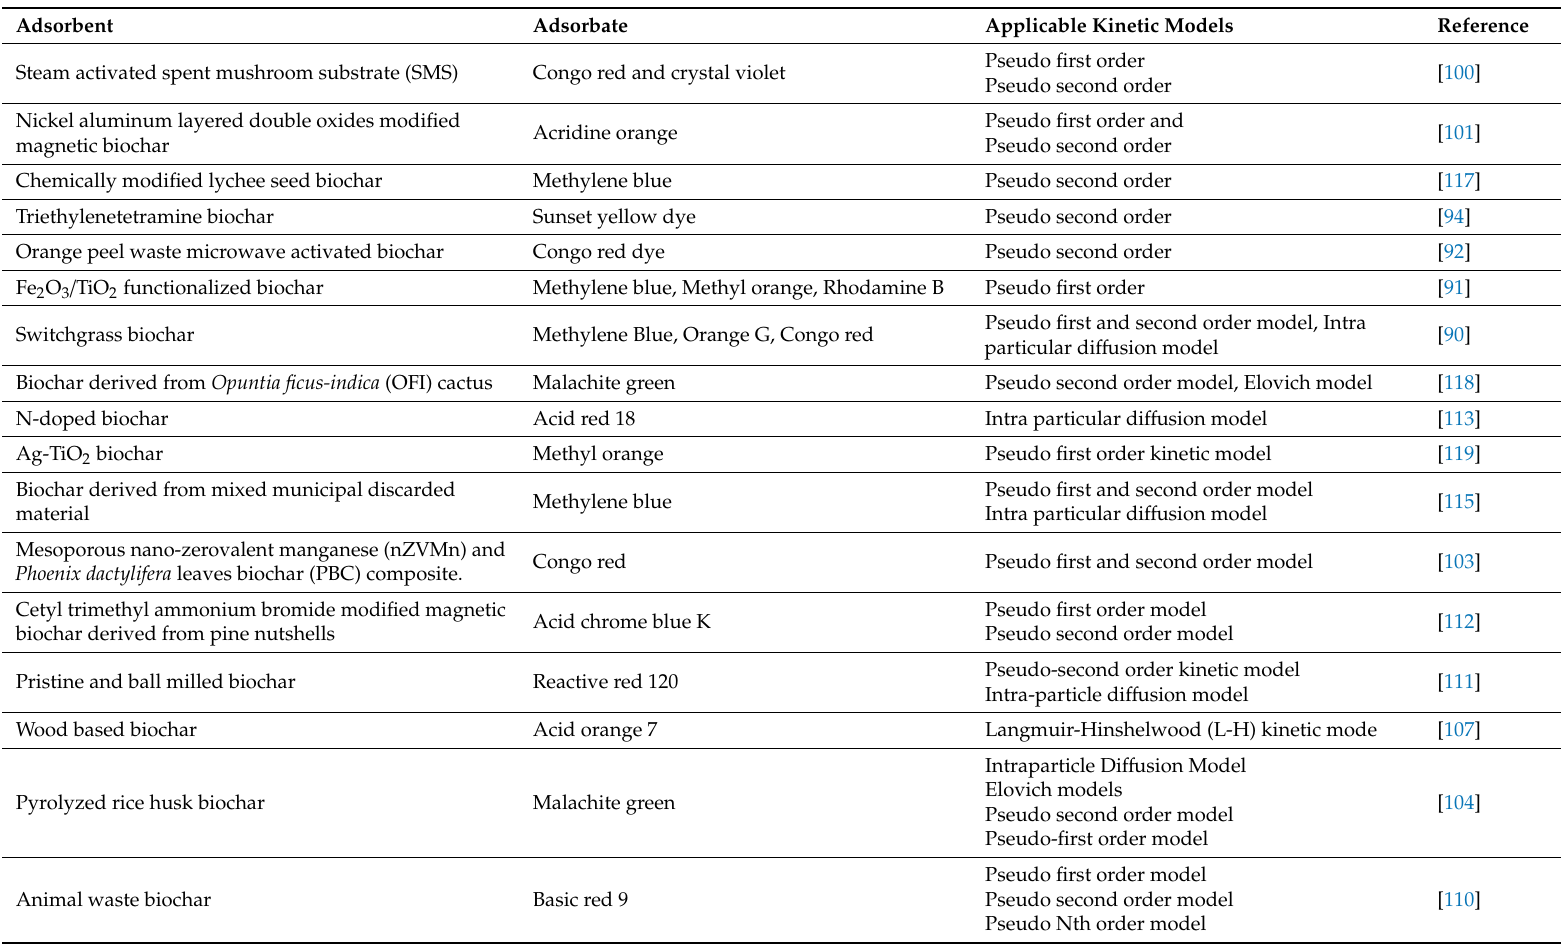
Table 2. Adsorption kinetic studies of di ff erent dyes onto